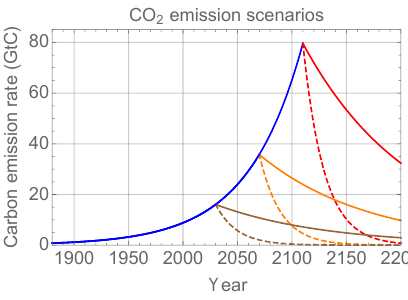
Figure 3. Blue curve is carbon emission rate R ( t ) scenario obtained by fitting the exponential S 0 exp( gt ) to the emission rate 4Gt C yr − 1 in 1960 and 11Gt C yr − 1 in 2010AD. The solid, brown, orange, and red curves are the subsequent R ( t ) after initiation of a 1% re- duction in the emission rate per year. The dashed curves are the corresponding rates with a 5% reduction per